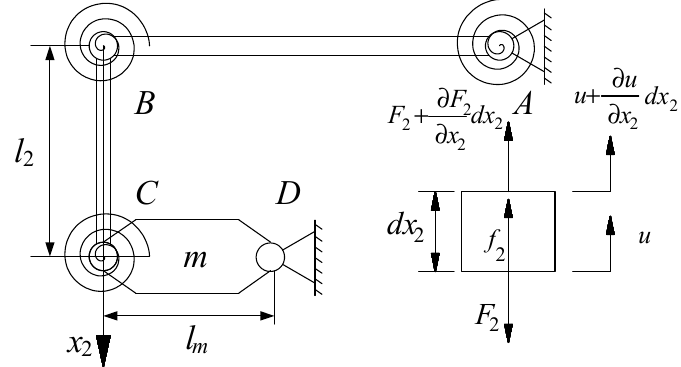
Figure 7. Free vibration model of intermediate beam mass.